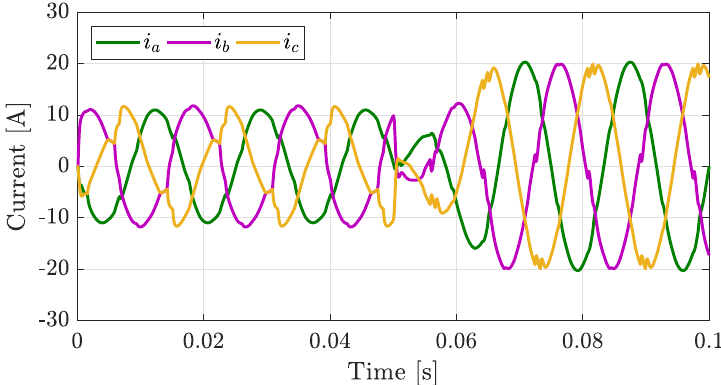
Figure 16. Compensation of PI controller tuned by poles placement method under unbalanced linear and nonlinear conditions.